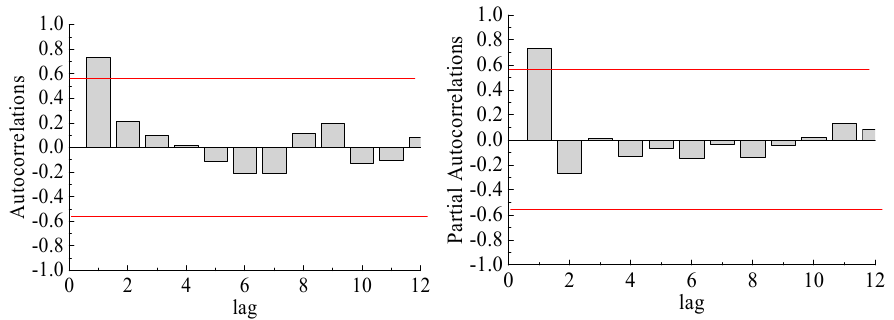
Figure 16. Autocorrelation coefficient and partial autocorrelation coefficient of the casing pressure time series after the first-order difference. Table 8. White noise test results and AIC and SBC values of the residual sequences.